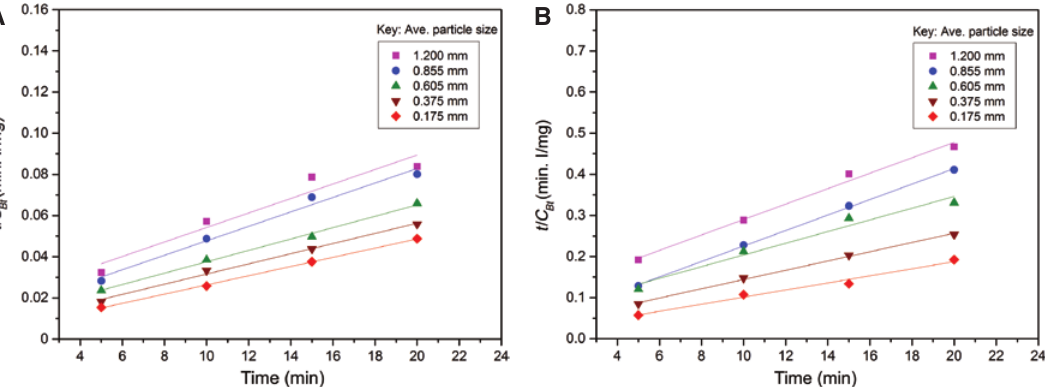
Figure 11: Second-order kinetic model testing for for the green solid-liquid extraction of andrographolide from Andrographis paniculata (AP) at 80 ° C for different particle sizes and solid-liquid ratios of (A) 1:10 (g ml -1 ) and (B) 1:50 (g ml -1 ).